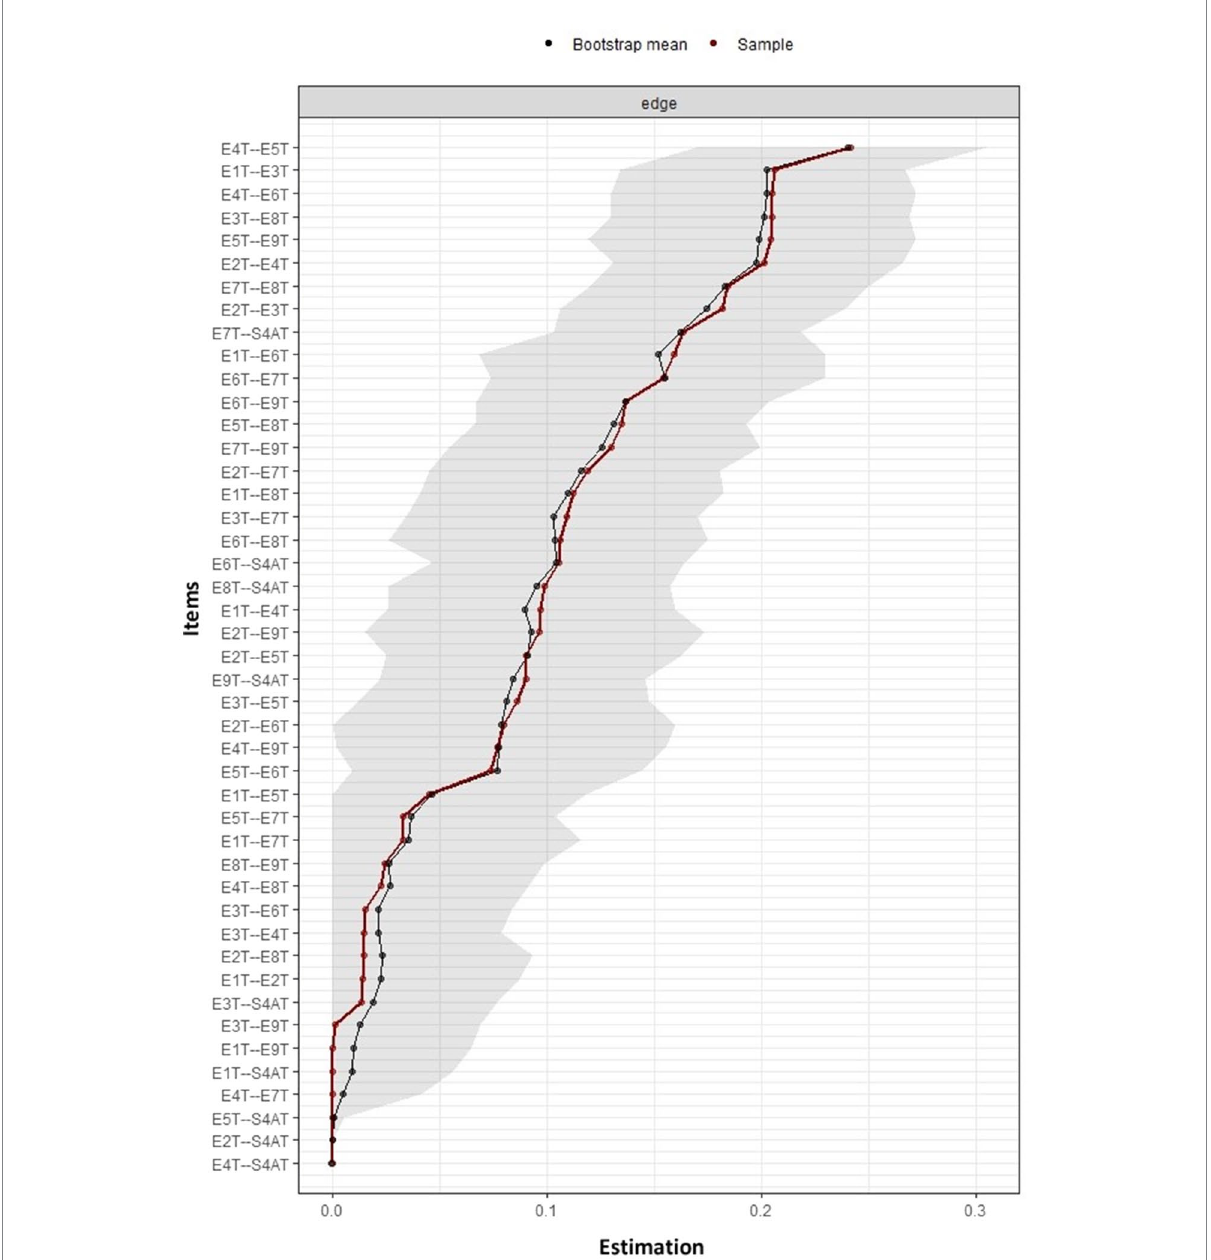
FIGURE 4 Accuracy of edge weight estimation and 95% CIs based on the Bootstrapping method. The precision of the edge weights is shown, where the red line indicates the sample edge weight (ordered in increasing order) and the gray bars are the 95% CIs based on the Bootstrapping method. T1: type 1; T2: type 2; T3: type 3; T4: type 4; T5: type 5; T6: type 6; T7: type 7; T8: type 8; T9: type 9; S4AT: healthy personality to psychosocial